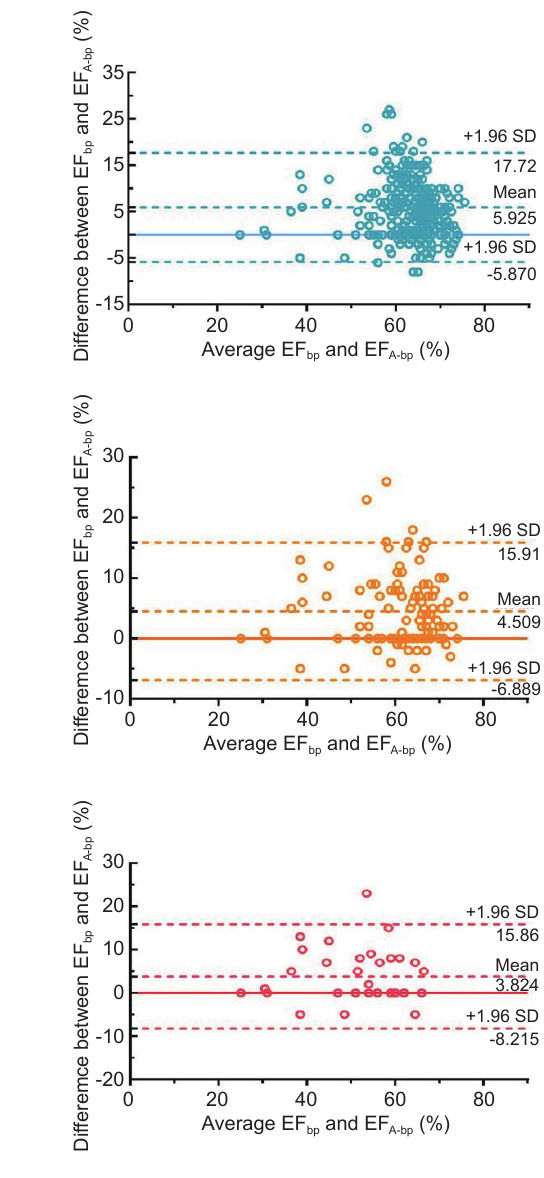
Figure 2 Correlations and Bland–Altman analysis of EF between different methods. (left) Correlation plots and (right) Bland-Altman plots for manual EF vs. automated EF in the common group (A and B), CHD group (C and D), WMA group (E and F). CHD, cardiac heart disease; WMA, wall motion abnormalities; ICC, intraclass correlation coefficients; CI, confidence interval; 95% LoA, 95% limits of agreement; EF, ejection fraction; EF bp was parameter by manual method; EF A-bp was parameter by automated